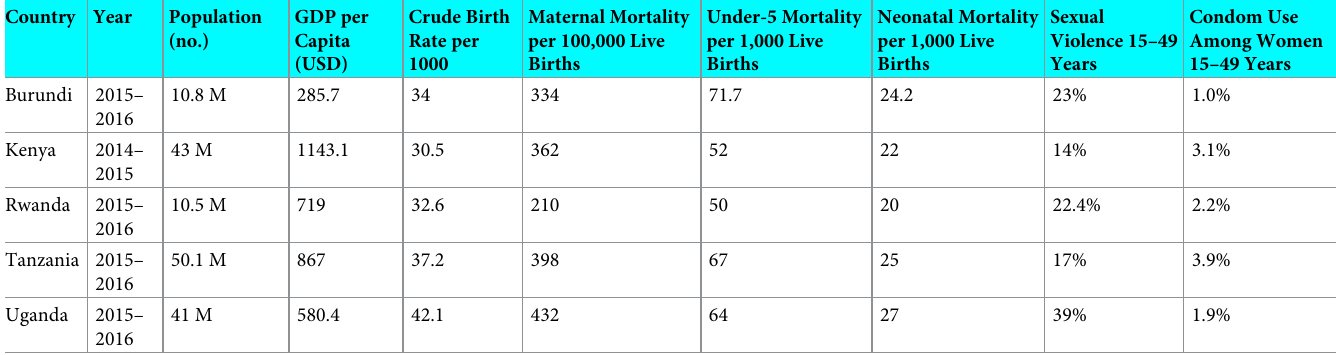
Table 1. List of East African countries included in